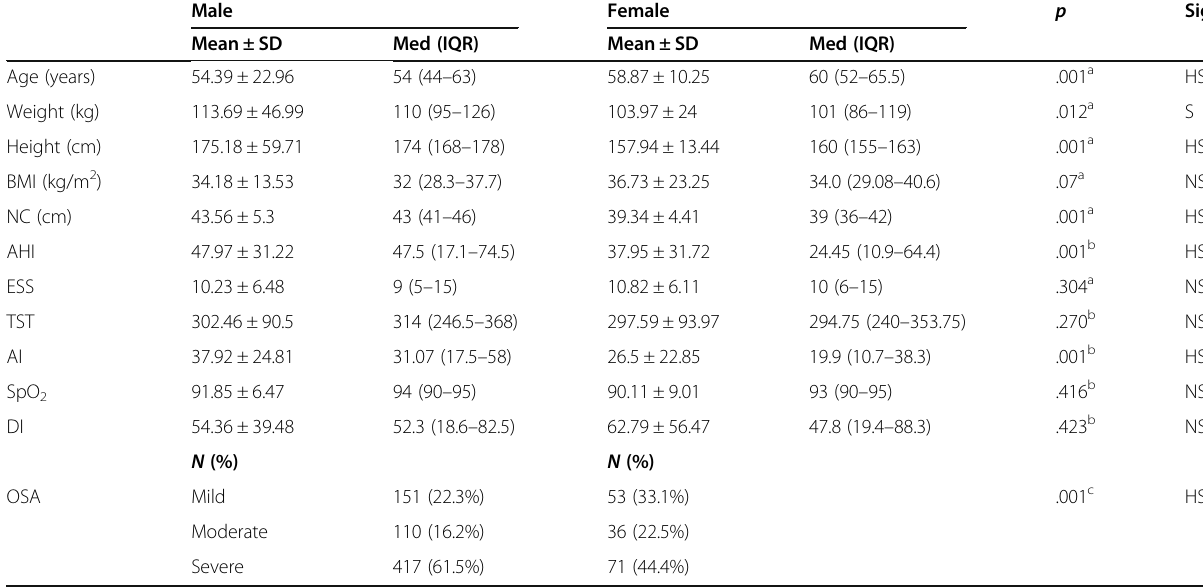
Table 7 Comparison between men and women diagnosed with OSA